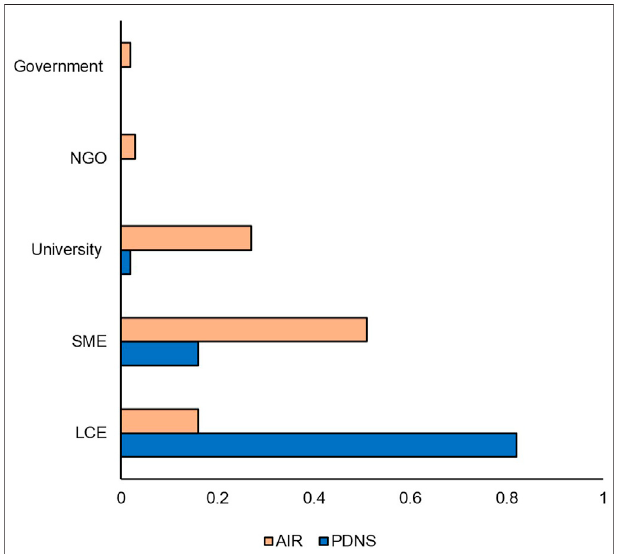
FIGURE 7 | Traits comparison. Traits were categorized using common USDA ERS designations. Percentages indicate the share of the total number of times that category occurred in the data set. Comparison is from 2011 to